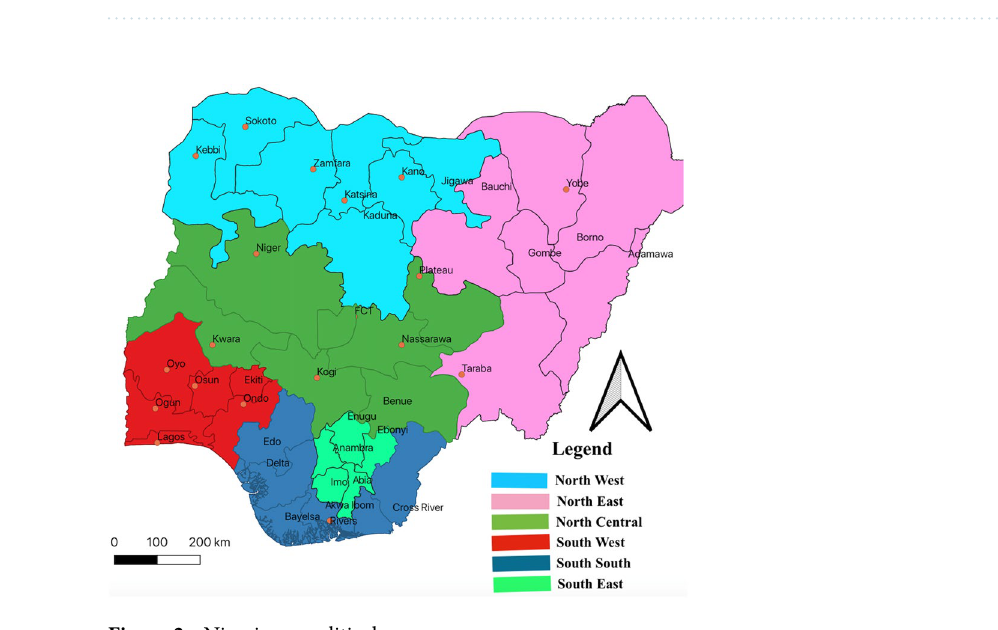
Figure 1. ( a ) Maternal mortality rate in Nigeria 26 ( b ) Maternal mortality ratios for different geopolitical zones in Nigeria 28 .